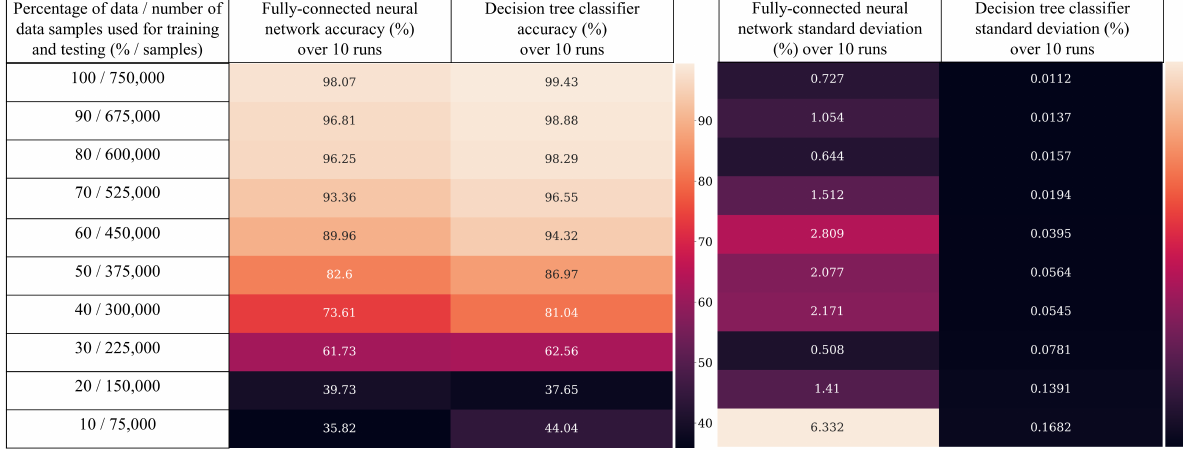
Figure 2. This is a wide figure. Figure 6. A chart comparing the percentage accuracy and standard deviation of neural networks and decision trees trained on varying subsets of the testing and training datasets, ranging from 100% to 10% of the total data.